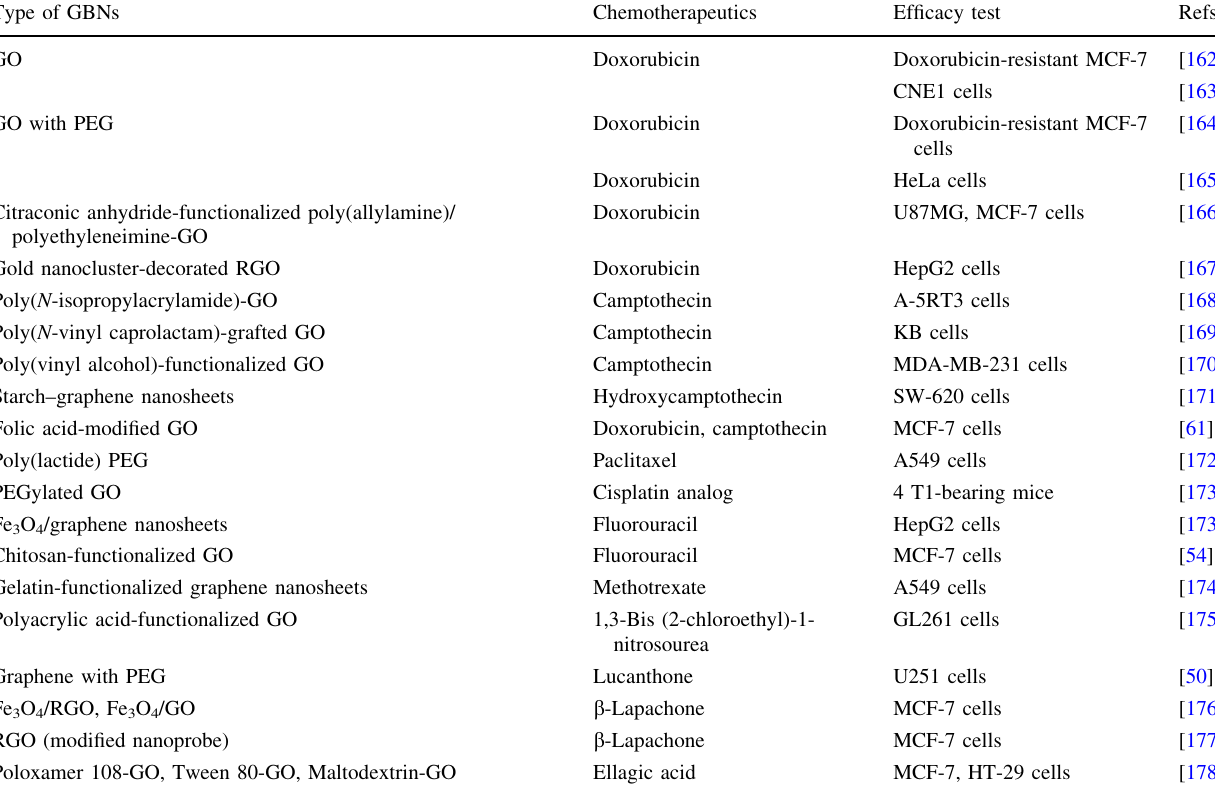
Table 2 GBNs loaded with chemotherapeutics [24]. Copyright (cid:2) Elsevier 2016 Type of GBNs